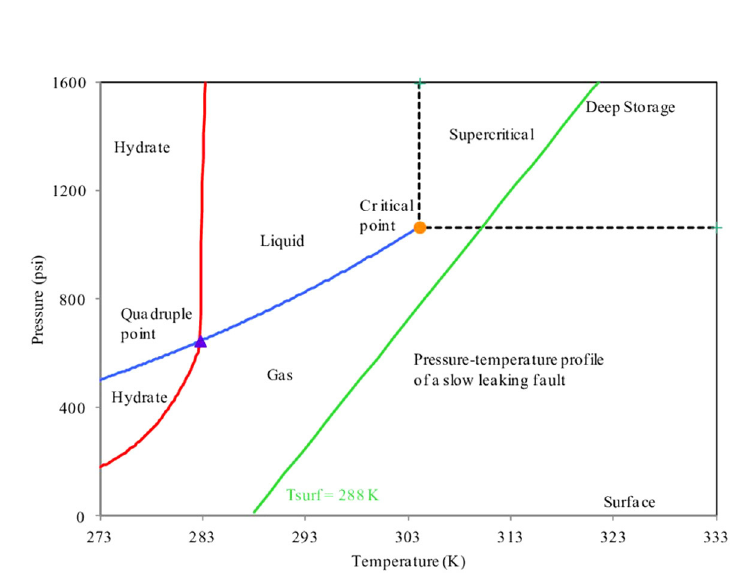
Fig. 11. – CO 2 phase diagram. The green line is a possible path of a CO 2 molecule moving from the reservoir up to the surface along a leaking fault. Depending on the temperature and thermal gradient, phase changes may occur